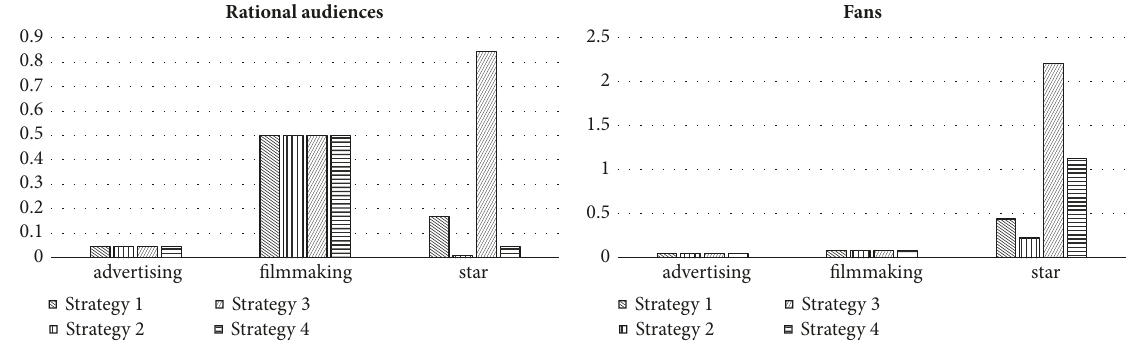
Figure 1: Investment analysis of spectator heterogeneity.